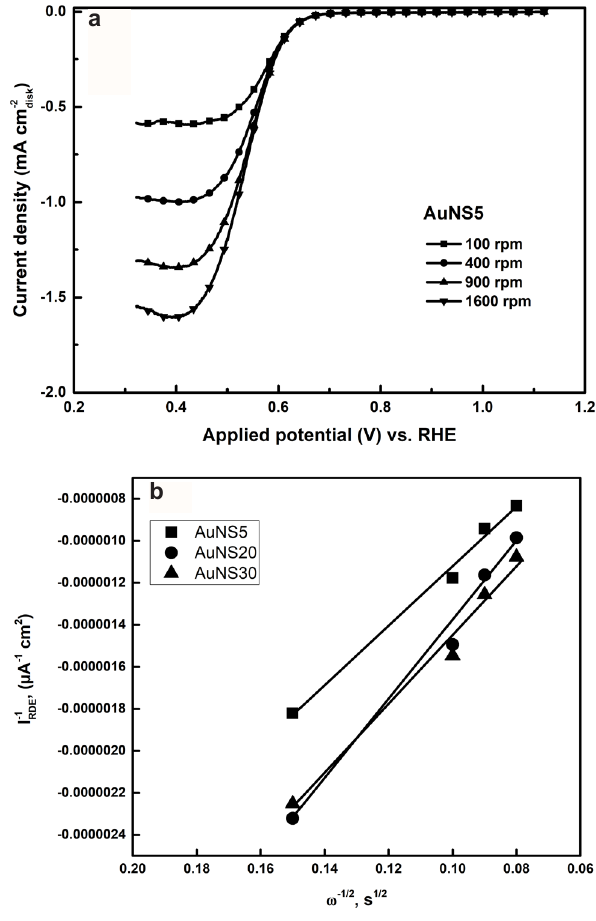
Fig. 4(a). The ORR activities of AuNS5 at 100, 400, 900, and 1600 rpm. (b) Kottecky-Levich plots of AuNS5, AuNS20 and AuNS30 at 0.5 V vs.